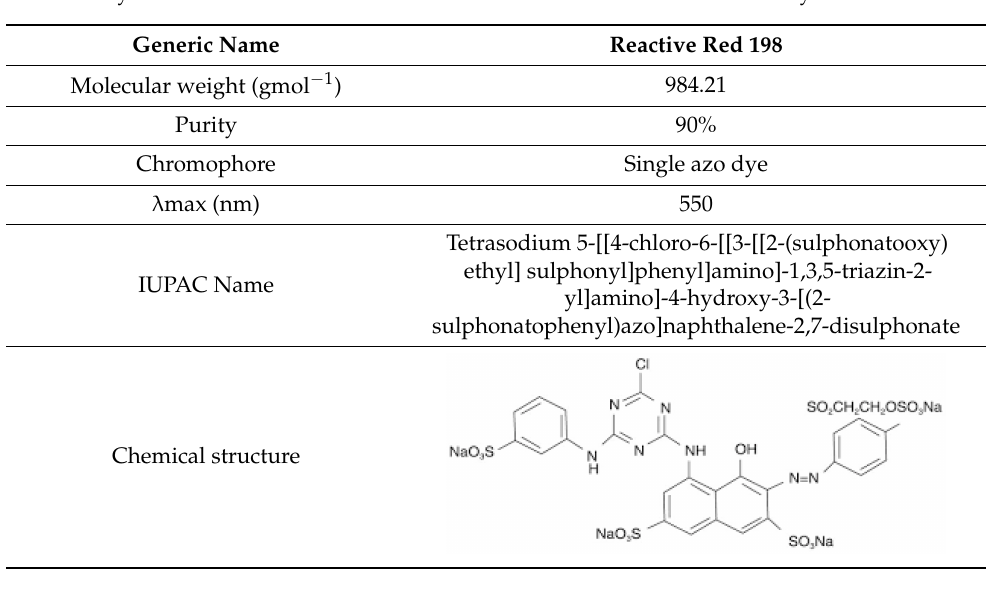
Table 1. Physicochemical characteristics and chemical structure of reactive red dye